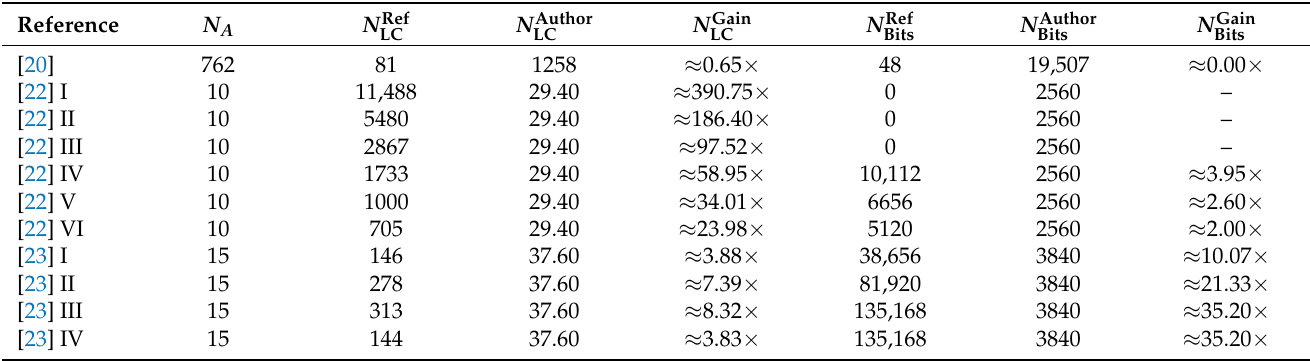
Table 6. Hardware area occupation